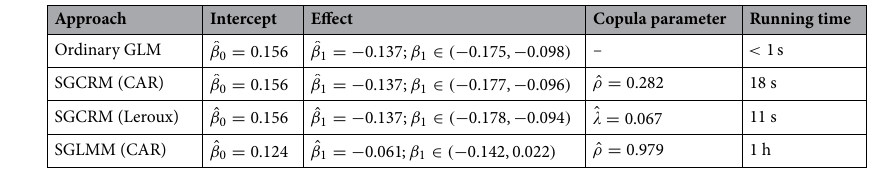
Table 4. Results for analyses of the Slovenia stomach cancer data. The first row shows results for an ordinary Poisson regression with offset. The second row shows results for the two-stage SGCRM procedure, where the first stage employed an ordinary Poisson regression with offset. The third row shows results for the SGCRM procedure with Leroux copula. The fourth row shows results for an SGLMM fit such that the linear predictor for the Poisson regression with offset was augmented with proper CAR spatial random